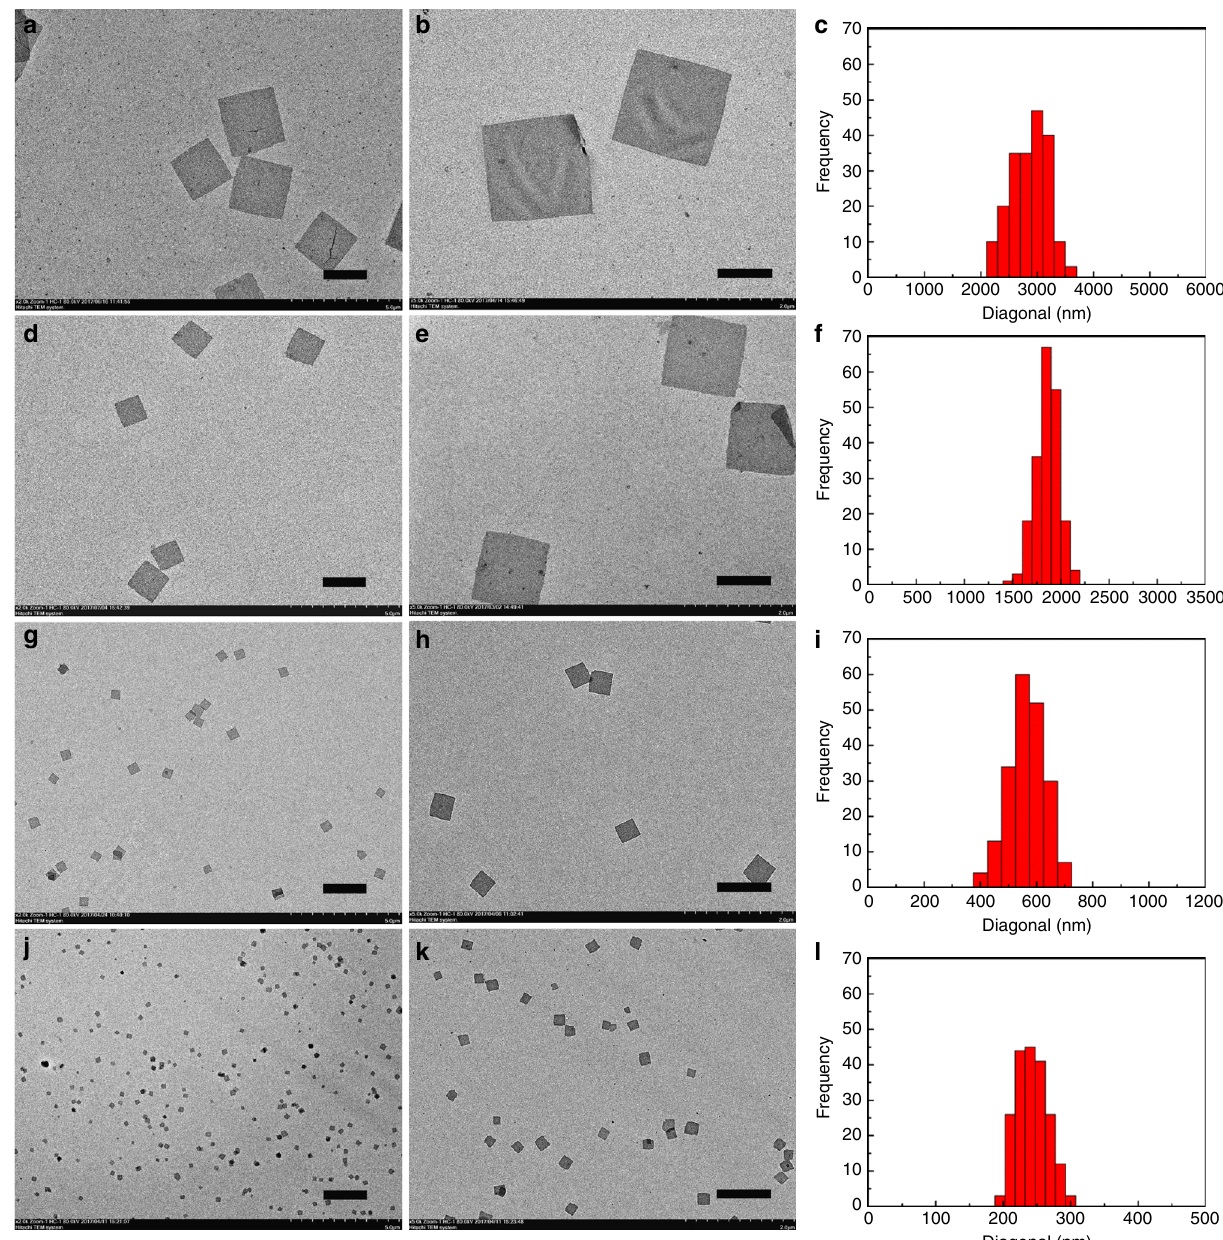
Fig. 1 2-D square micelles grown from PPV 12 - b -P2VP n with varying ratio of PPV and P2VP blocks ( R PPV/P2VP ). TEM images of representative sample of 2-D square micelles prepared from a , b 0.01 mg ml − 1 2-PrOH solution of PPV 12 - b -P2VP 12 ( R PPV/P2VP = 1 : 1), d , e 0.01 mg ml − 1 2-PrOH solution of PPV 12 - b -P2VP 16 ( R PPV/P2VP = 1 : 1.3), g , h 0.05 mg ml − 1 2-PrOH solution of PPV 12 - b -P2VP 22 ( R PPV/P2VP = 1 : 2), j , k 0.05 mg ml − 1 2-PrOH solution of PPV 12 - b -P2VP 36 ( R PPV/P2VP = 1 : 3), and c , f , i , l contour length distributions of the diagonal length of correspondent 2-D square micelles. Scale bars in images a , d , g , j are 2 μ m, whereas scale bars in images b , e , h , k are 1 μ